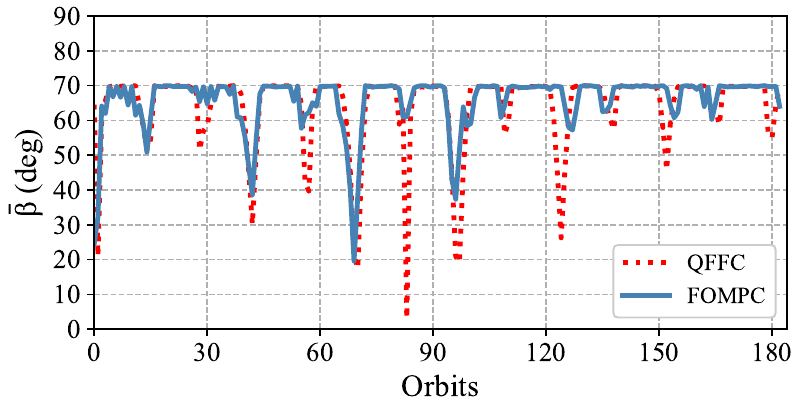
Figure 8. The half-year time histories of ¯ β for the QFFC and the FOMPC. Compared with the blue curve representing the FOMPC in Figure 7, the red